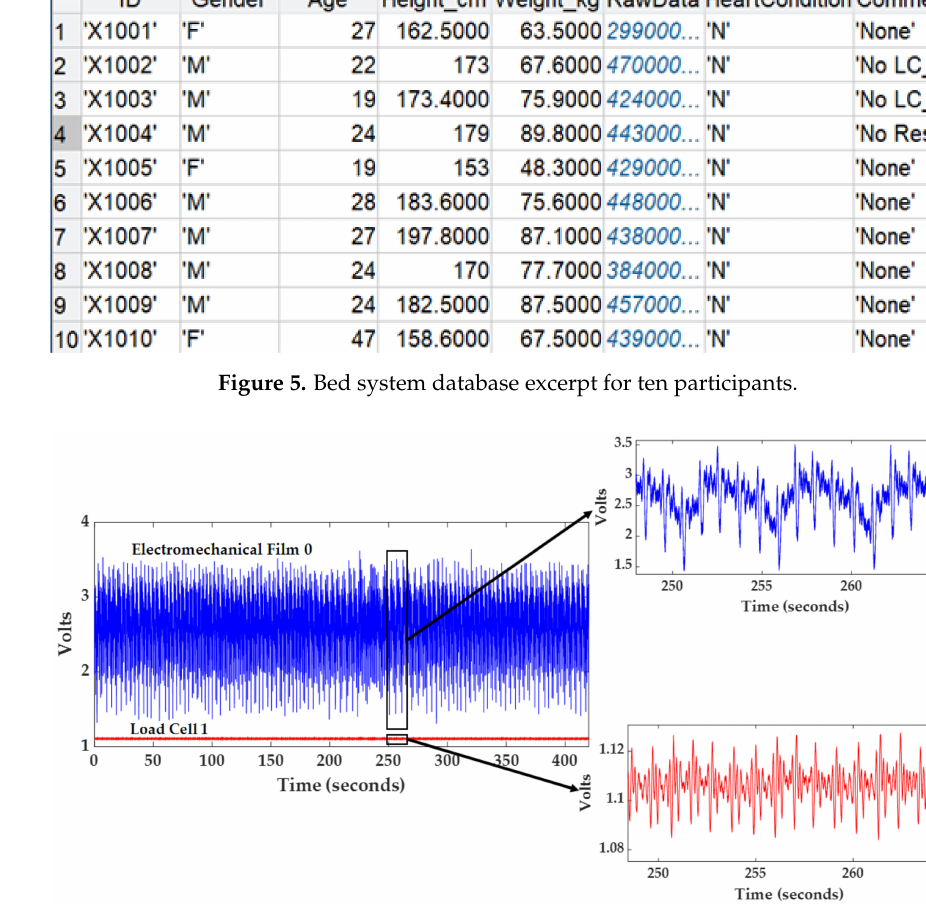
Figure 6. Representative raw signals collected from participant